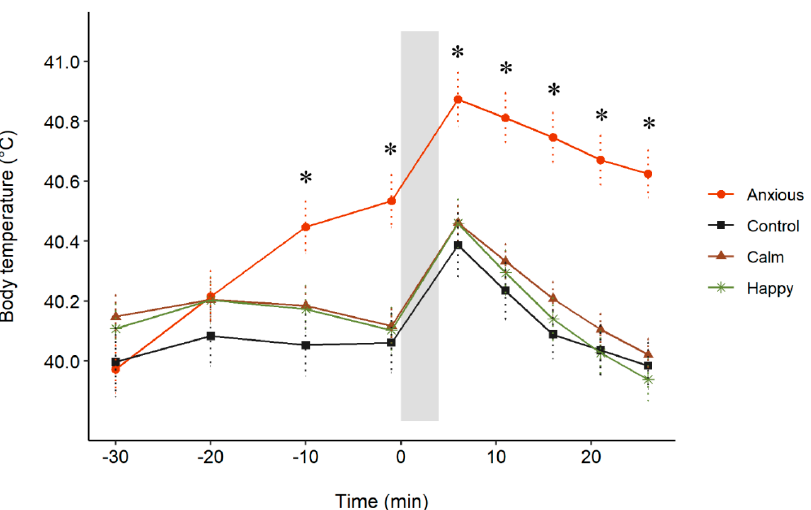
Figure 4. Mean s.e.m. body temperature for each treatment group before and after attention bias testing. All drugs were administered at time − 30. Attention bias testing occurred between times 0 and 3 (grey bar). The “*” symbols denote a significant difference between the Anxious group and other treatment groups at a given time point, determined using a repeated measures linear mixed model. No differences were observed between the Control, Calm and Happy groups.